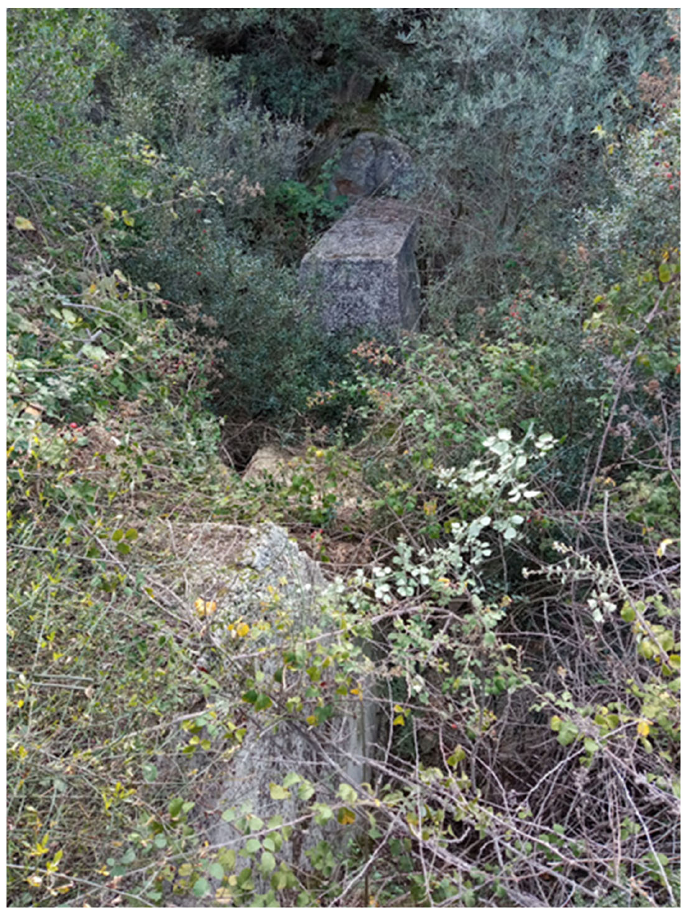
Figure 9. Check ‐ dam in the study area which is almost totally covered by dense vegetation. Figure 9. Check-dam in the study area which is almost totally covered by dense